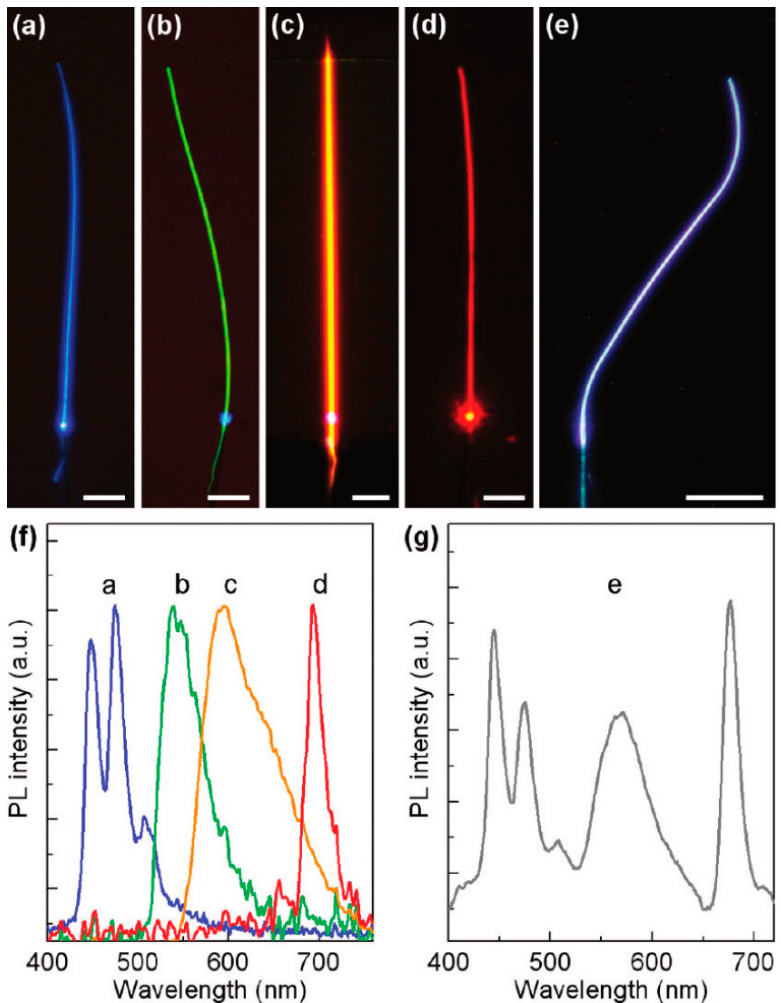
Figure 4. ( a – e ) Fluorescence microscopy images of a nanofiber with blue, green, orange, red, and white fluorescence emission, respectively. ( f , g ) PL spectra corresponding to the nanofiber emissions shown in a–e (the whole Figure 4 was reprinted with permission from Gu et al. [41]).